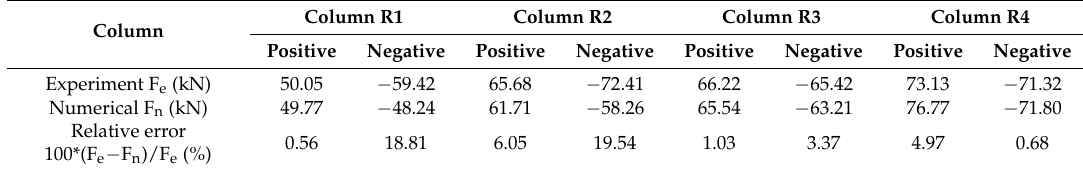
Table 9. Comparison of the strength between the experiment and numerical analysis.